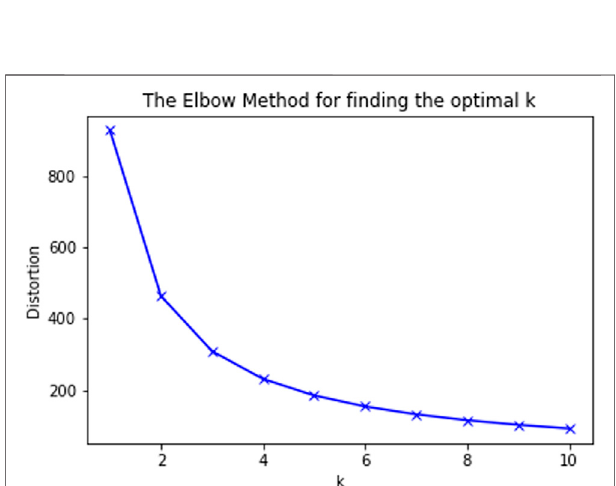
FIGURE 5 | Elbow plot for K-means clustering.